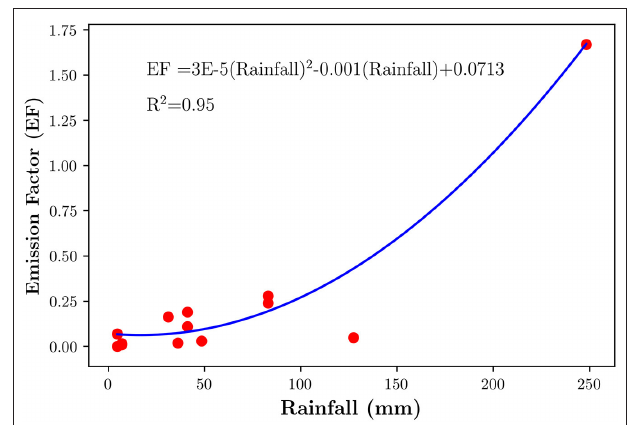
FIGURE 2 | Relationship between EF and rainfall obtained using Byrnes et al. (2017), Chirinda et al. (2019), Durango (unpublished) data and measurements conducted in the current study. At each site, rainfall data includes recordings of precipitation events from 8 days before greenhouse gas measurement commenced to the end at the gas measurement period. The model was chosen based on statistical fit ( R 2